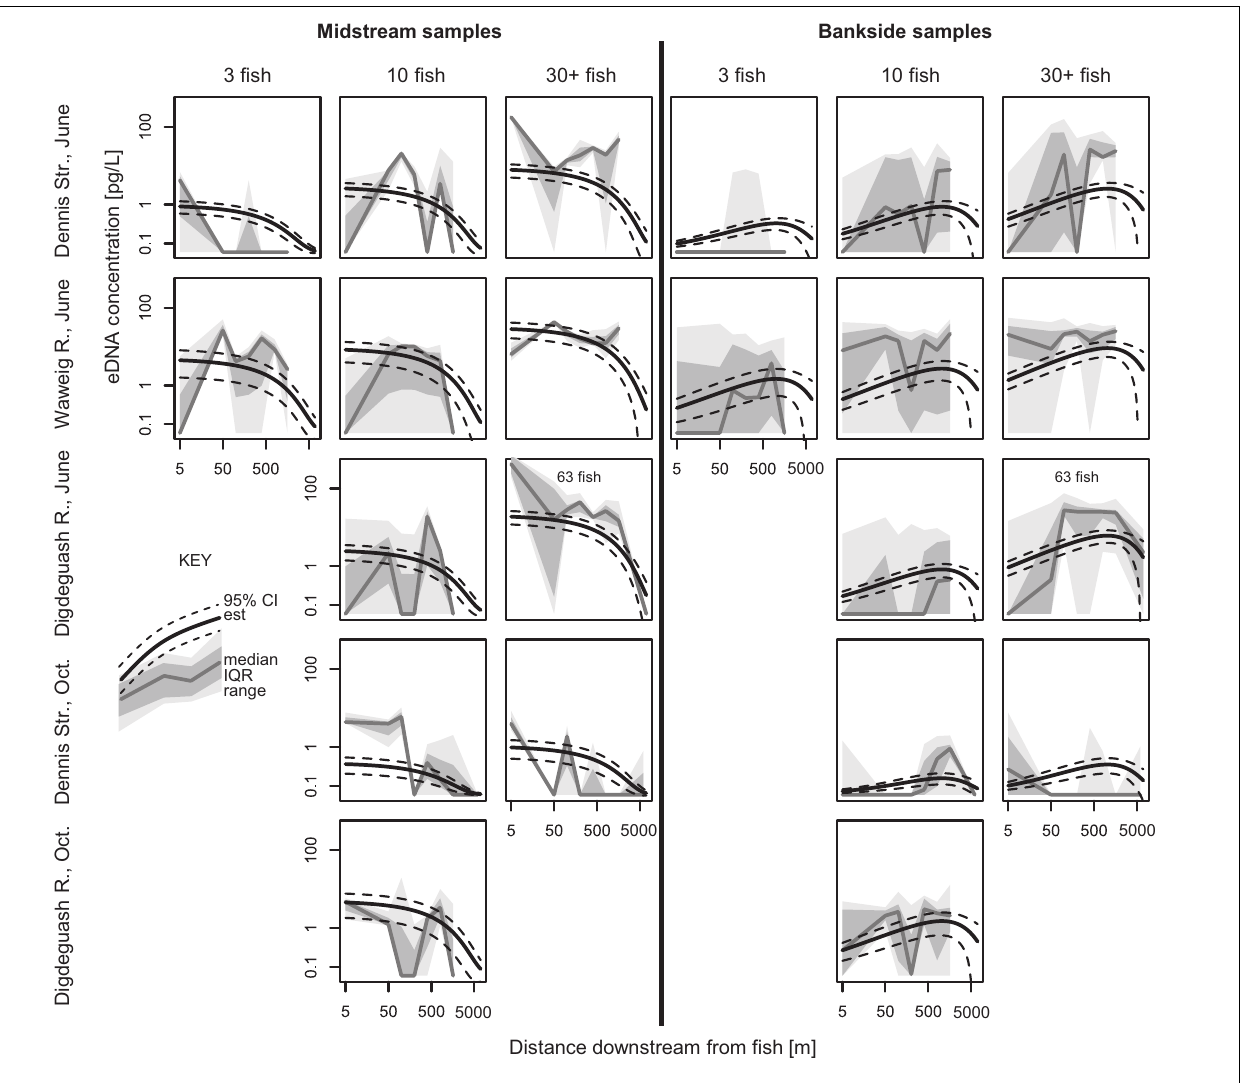
FIGURE 6 | eDNA concentration versus downstream distance from fish, separated for midstream and bankside samples. Data distributions, model estimates, and model estimates confidence intervals (CI) are shown. IQR, inter quartile range. For analogous eDNA detection rate data, see Supplementary Figure 1 .